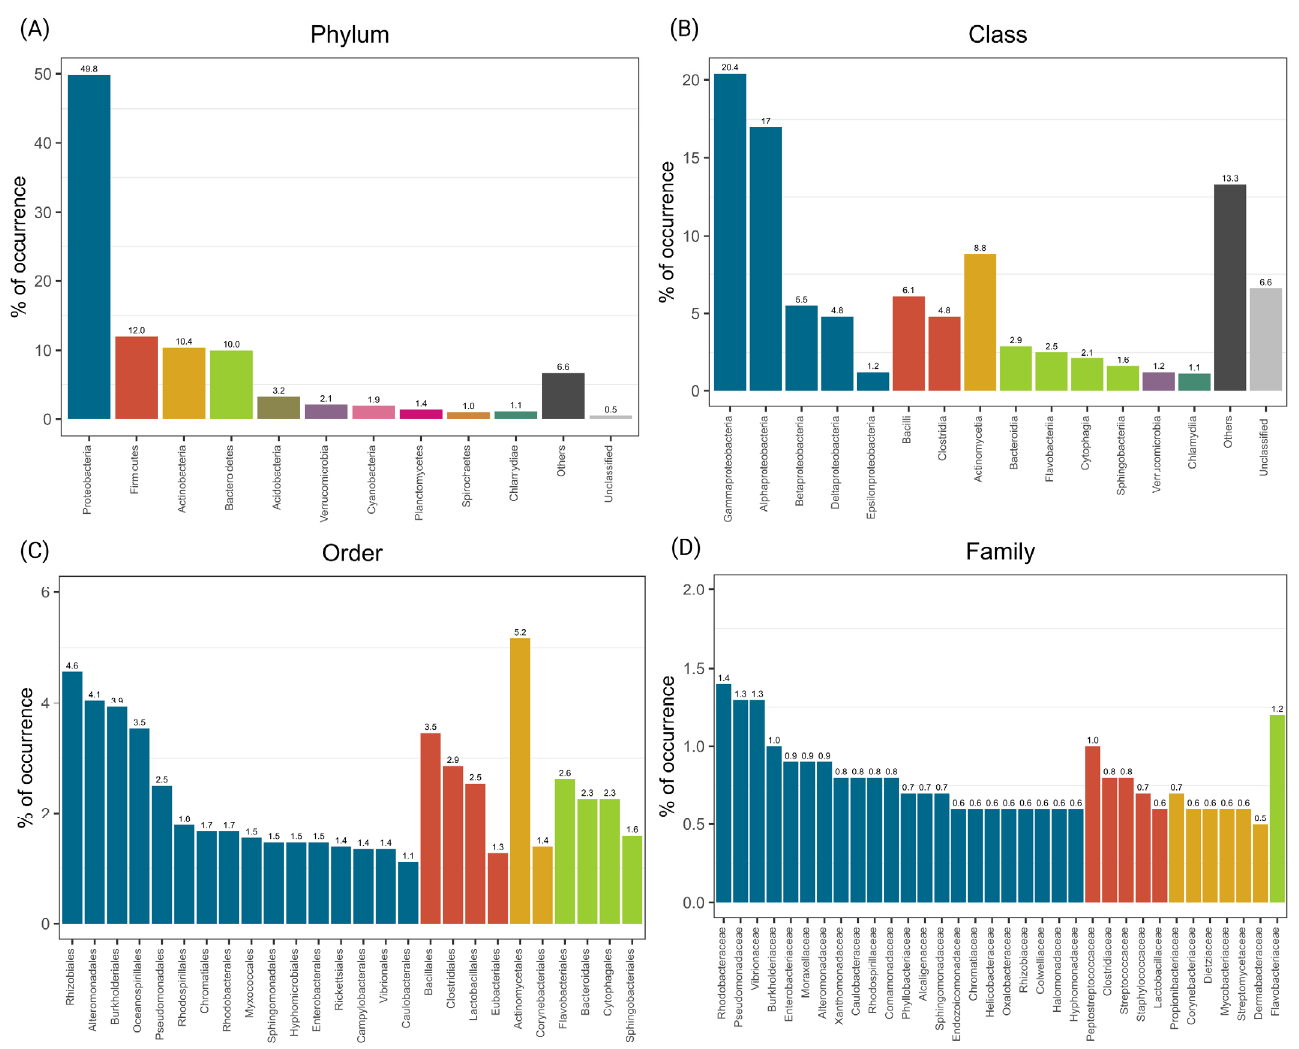
Figure 2. Coral-associated bacteria across all coral species and studies, grouped at four different taxonomic levels. ( A ) Phylum; ( B ) Class; ( C ) Order and ( D ) Family. For each graph, the Y-axis represents the percentage of occurrence. Groups with the lowest occurrence in the different taxonomic levels were grouped into “Others”. Unclassified groups and “Others” for order and family levels are available in Supplementary Material S2. Colors used for class-, order- and family-level graphs represent members of the same phylum.